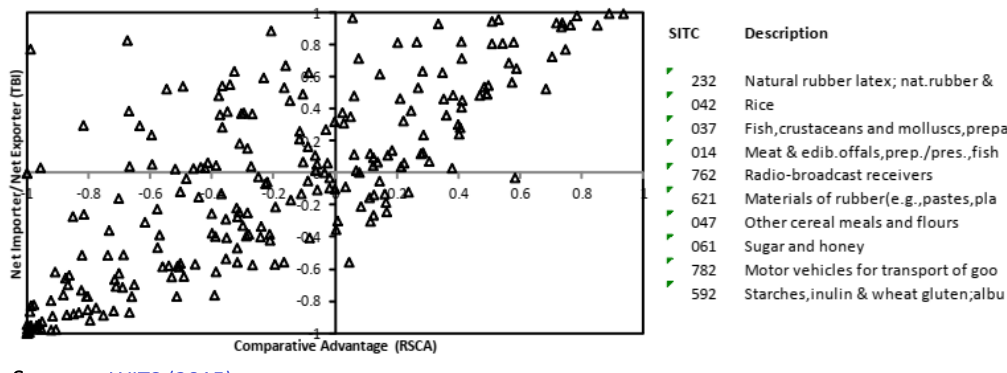
Figure 16: Products Mapping and the Top-Ten Export Products of Thailand, 1997